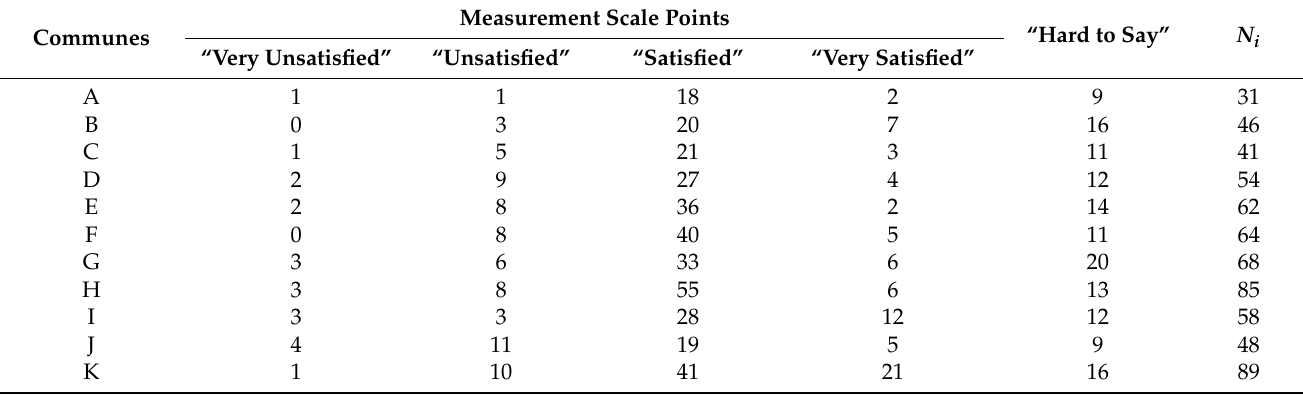
“Hard to Say” N i